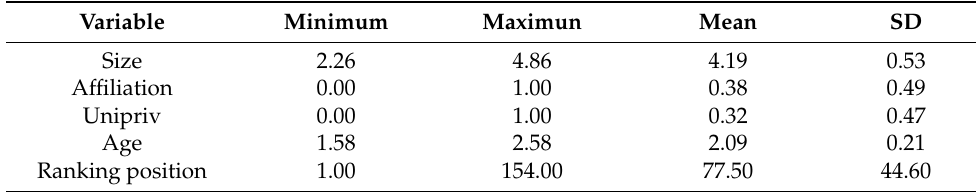
Table 5. Descriptive statistics independent